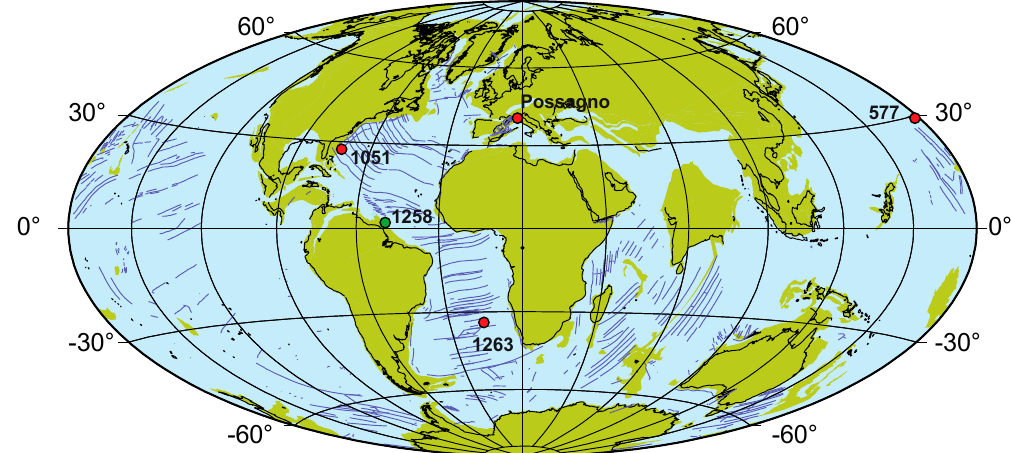
Figure 1. Approximate location of Site 1258 during the early Eocene (green dot). Also shown are locations of Deep Sea Drilling Project (DSDP) Site 577, Ocean Drilling Program (ODP) Sites 1051 and 1263, and the Possagno section (red dots), which each have bulk carbonate δ 13 C and planktic foraminiferal records spanning the Early Eocene Climatic Optimum (EECO) ( e.g., [19,41,42]) . Base map is from http://www.odsn/de/services/paleomap.html with paleolatitudes modified for Sites 577, 1051 and 1258 according to www.paleolatitude.org model version 1.2 [45] . Possagno paleolatitude is based on the http://www.odsn.de/odsn/services/paleomap/adv_map.html model. Note that locations might be adjusted to a different reference frame to account for changes in plate motion relative to the spin axis [3].